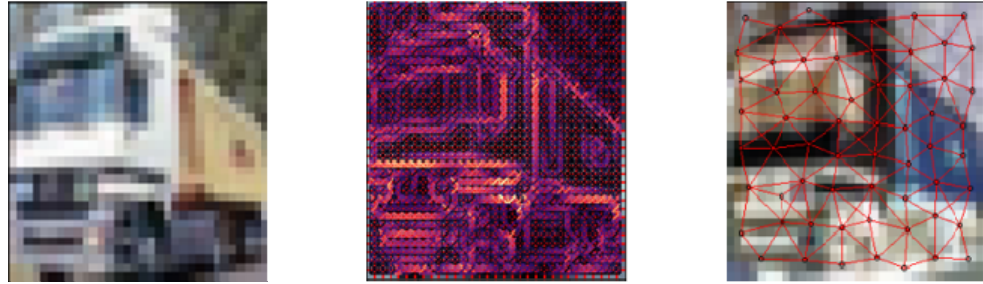
Figure 1. Sample of segmenting the original image into pixel-based and SLIC-based graph repre- sentation.